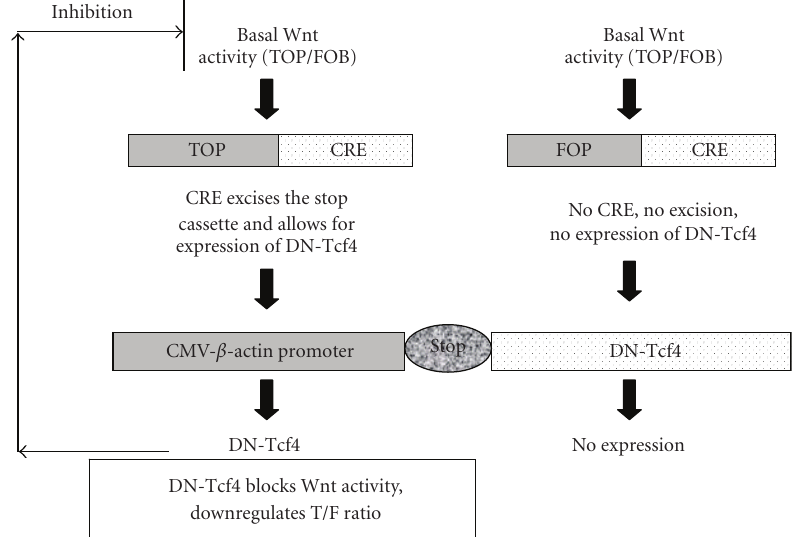
Figure 5: Negative downregulation using the modular Cre/lox system. Floxed e ff ectors can include negative repressors of the transcriptional activity driving Cre expression. For example, in this model system, DN-Tcf4, which inhibits Wnt activity, is expressed from a floxed vector in a Wnt activity-specific manner. The DN-Tcf4 feeds back to repress Wnt activity in a Wnt activity-specific manner. Generalized systems of this nature can be applied to other disorders in which constitutive high activation of cell signaling causes disease, adapted from